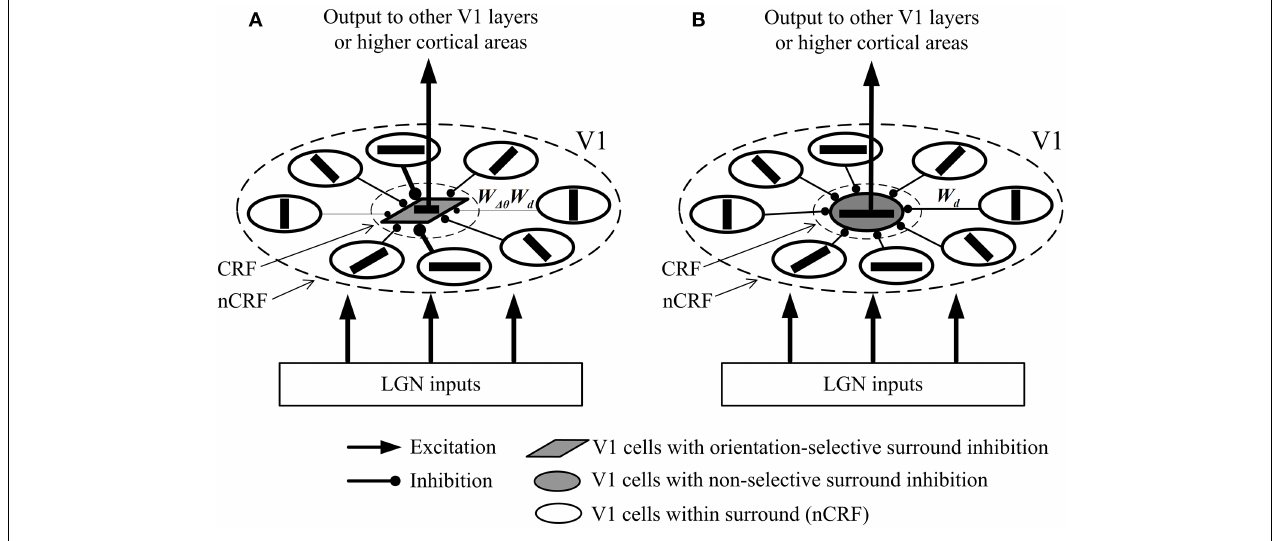
and W 1θ is a weighting determined by the angle difference between the preferred orientations of the pre-synaptic and post-synaptic cells. (see Equation 9). (A) The local network of a V1 cell with orientation-selective surround inhibition. The synaptic strength of inhibition depends on both W 1θ and W d . (B) The local network of a V1 cell with non-selective surround inhibition. The synaptic strength of inhibition depends only on W d . Different widths of the connection lines signify different synaptic strengths: thicker lines denote stronger (inhibitory) synapses. For example, the lengths of different connections in (B) are equal, which results in the same widths of the connection lines and the equal synaptic strengths ( W d